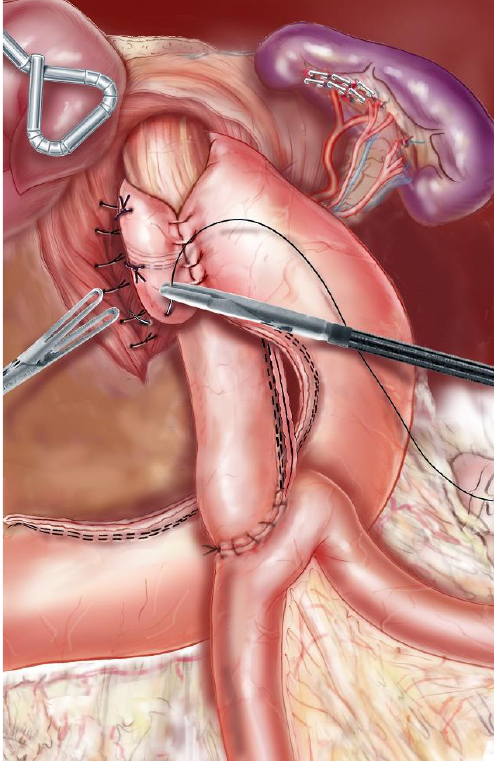
Figure 3. A 2.5 – 3 cm-long 360-degree wrap was created around the abdominal esophagus (Nissen technique).